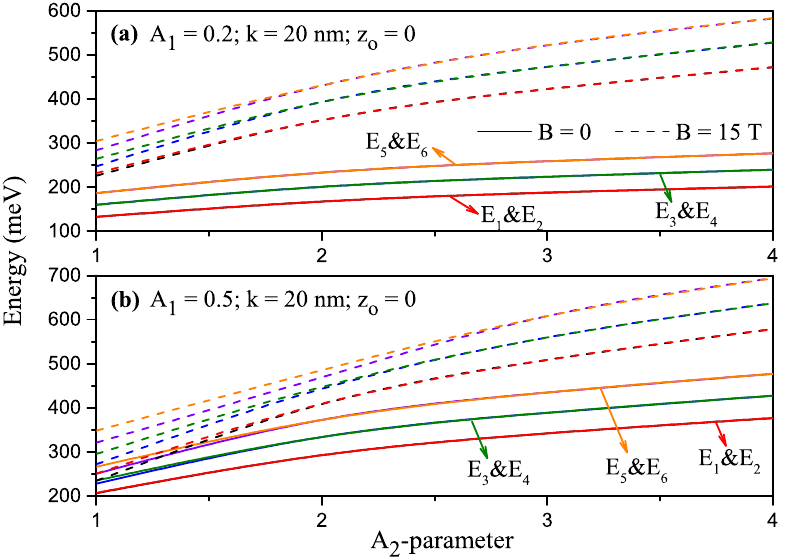
Figure 2. For k = 20nm and z 0 = 0, the variation of the energies corresponding to the first six lower-lying levels of a confined electron within Harmonic-Gaussian symmetric DQW as a function of the A 2 -parameter: A 1 = 0.2 ( a ) and A 1 = 0.5 ( b ). Solid (dashed) lines are for B = 0 ( B = 15T). For a constant A 2 -value ( A 2 = 2.0), the variation of the energies that corresponds to the first six lower-lying levels of a confined electron within H-G ADQW as a function of the z 0 -asymmetry parameter. Solid (dashed) lines are for A 1 = 0.2 ( A 1 = 0.5) in the absence and presence of the magnetic field are given in Figures 3a and 3b, respectively. While the first two energy levels are a direct decreasing function of the asymmetry parameter for both A 1 values, the first two energy levels are a direct decreasing function of the asymmetry parameter while the energies of the other levels increase and/or decrease according to the increasing z 0 parameter. The main reason for the oscillations of the energies is that the electrons at some other levels, except for the ground state, are localized in the right well. The level of electrons localized in the right well varies depending on the external parameters. For example, in Figure 3a, for A 1 = 0.2 and z 0 = 0.15, when there is no magnetic field, electrons in the third and fourth levels are localized in the right well, for A = 0.5, at the same z 0 value electrons in the fourth and sixth levels are localized in the right well. In the presence of the magnetic field, for A 1 = 0.5 and z 0 = 0.15, all electrons are localized above the potential barrier, i.e., in a wider well. The localization in the right or left well of electrons at different levels varies depending on external parameters. Figure